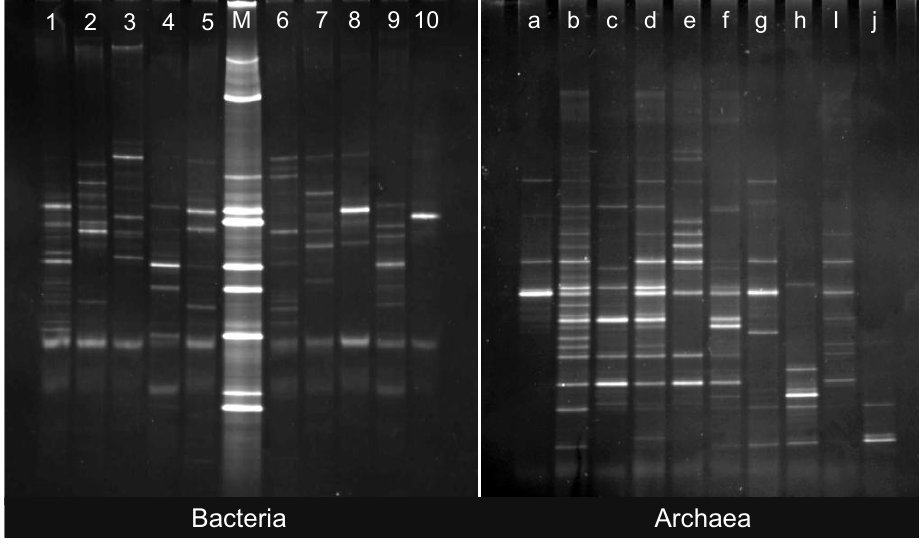
Figure 2. Denaturing gradient gels for Bacteria and Archaea. Left panel, Bacteria: ( 1 )